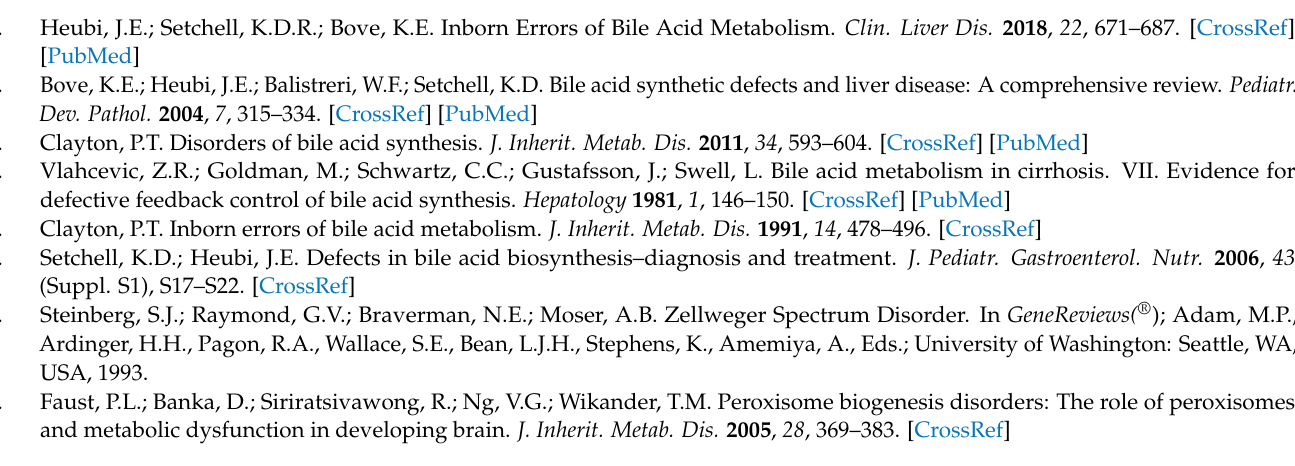
(b) MCA peaks at ± 22 min (chromatogram enlarged); Figure S5: Representative chromatograms of related substance HPLC-RI analysis of 250 mg CA capsules at T0 and T12, stored under